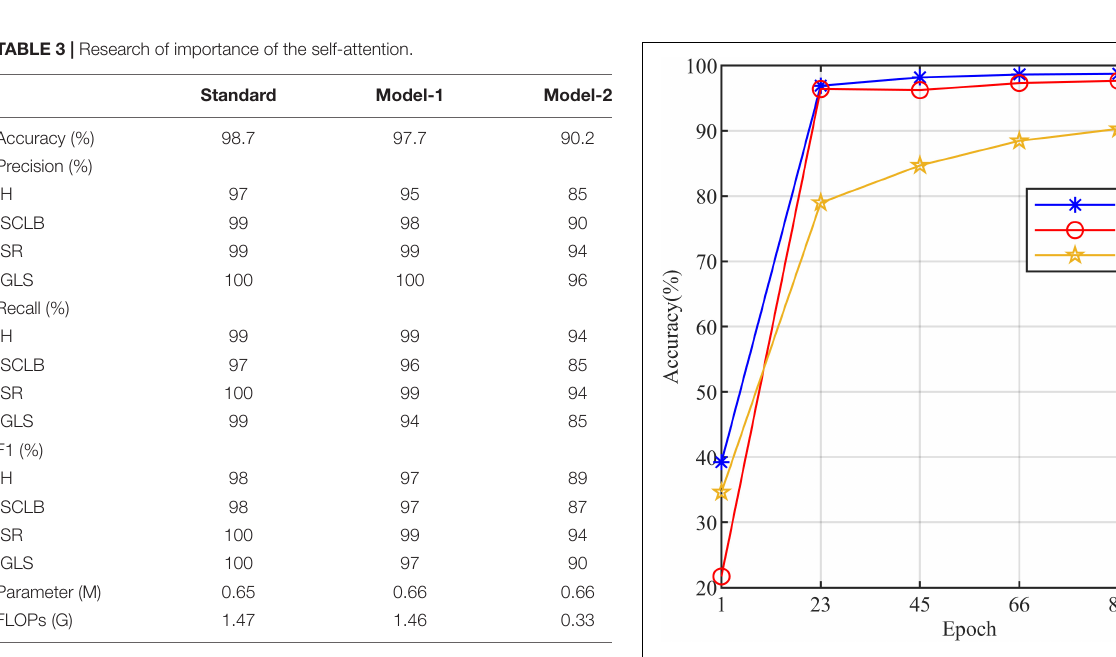
FIGURE 9 | Confusion matrices of all models of this article (i.e., Model-1 and Model-2).